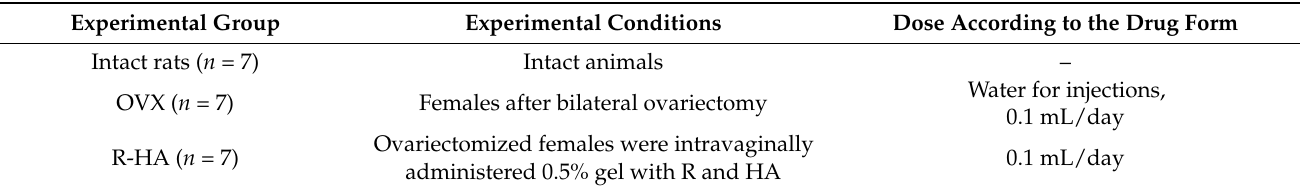
Table 2. Experimental groups and experimental